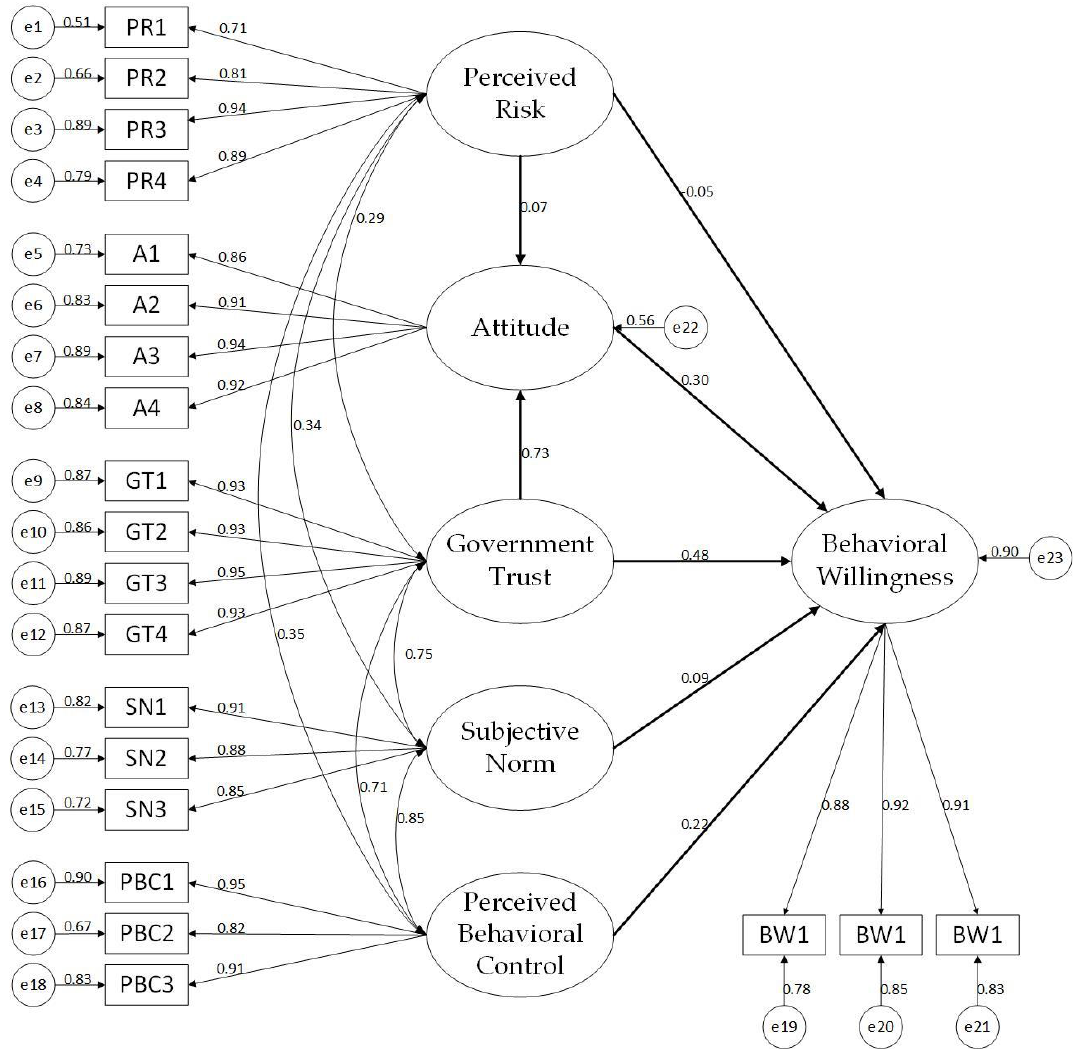
Figure 2. Initial measurement model of residents’ behavioral willingness. Table 6. Goodness-of-fit of the initial measurement model.